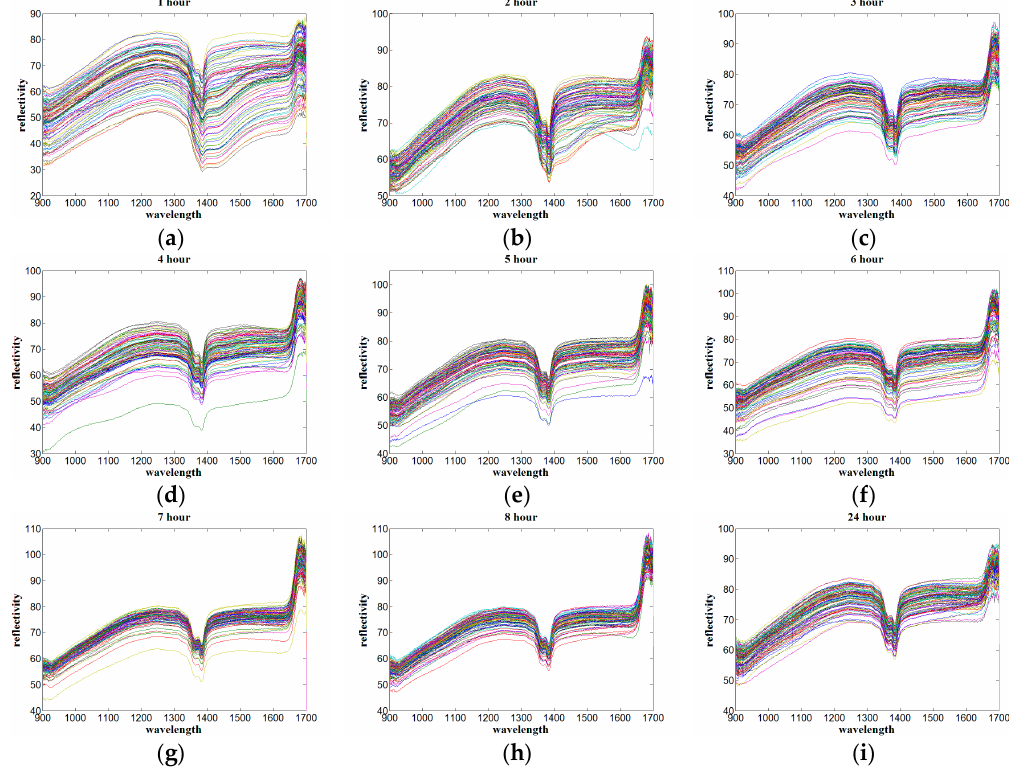
Figure 1. Near infrared reflectivity spectra of soil at different drying time. ( a – i ) represent the drying time from 1 h to 8 h and 24 h respectively.